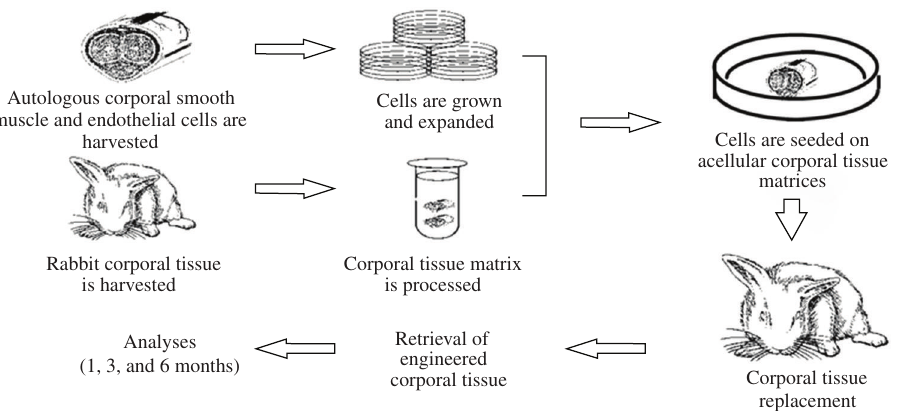
FIGURE 1: Using tissue engineering techniques to create entire penile